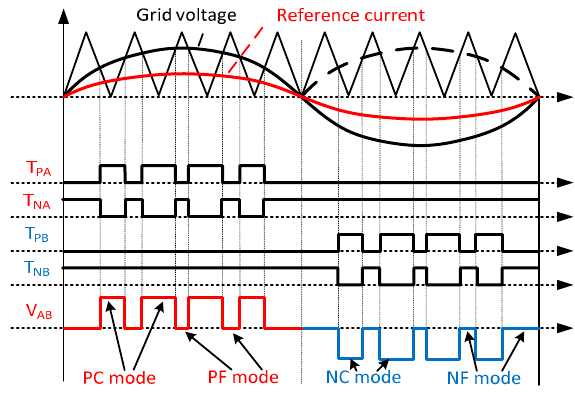
Figure 5. The principle of USPWM.